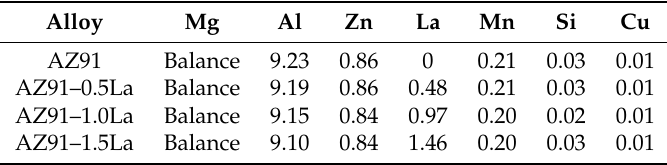
Table 1. The experimentally measured chemical composition (mass fraction) of AZ91-La alloys.